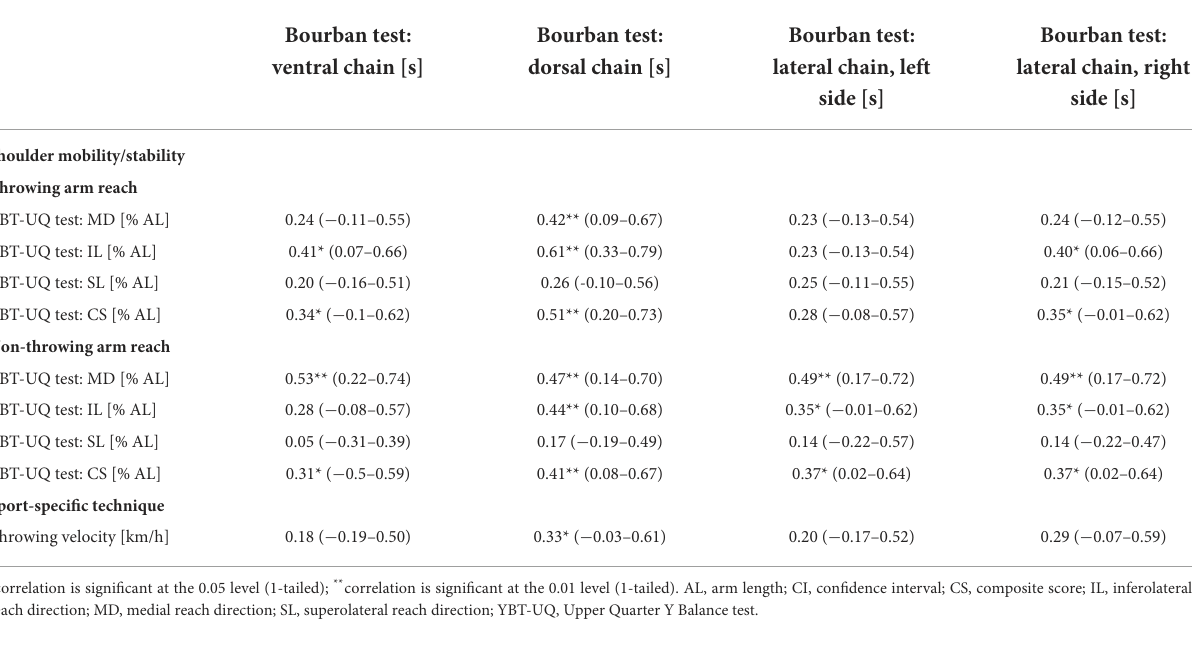
TABLE 3 Pearson correlations with 95% confidence interval between core muscle strength endurance and upper-extremity performance (i.e., shoulder mobility/stability and throwing velocity).